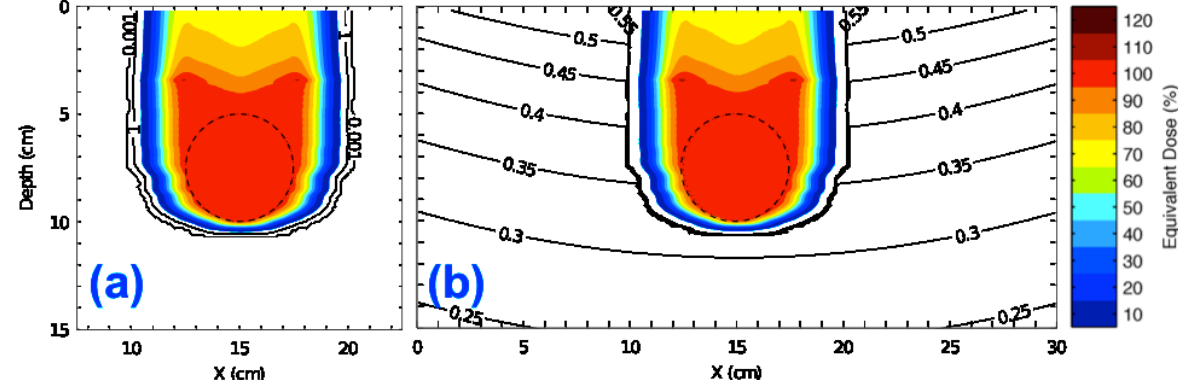
Figure 1. Equivalent dose distributions in planes in the lateral and axial directions for the spherical target in water showing ( a ) proton equivalent dose only and ( b ) combined proton and neutron equivalent dose. Data are shown as percentages of the prescribed target equivalent dose.